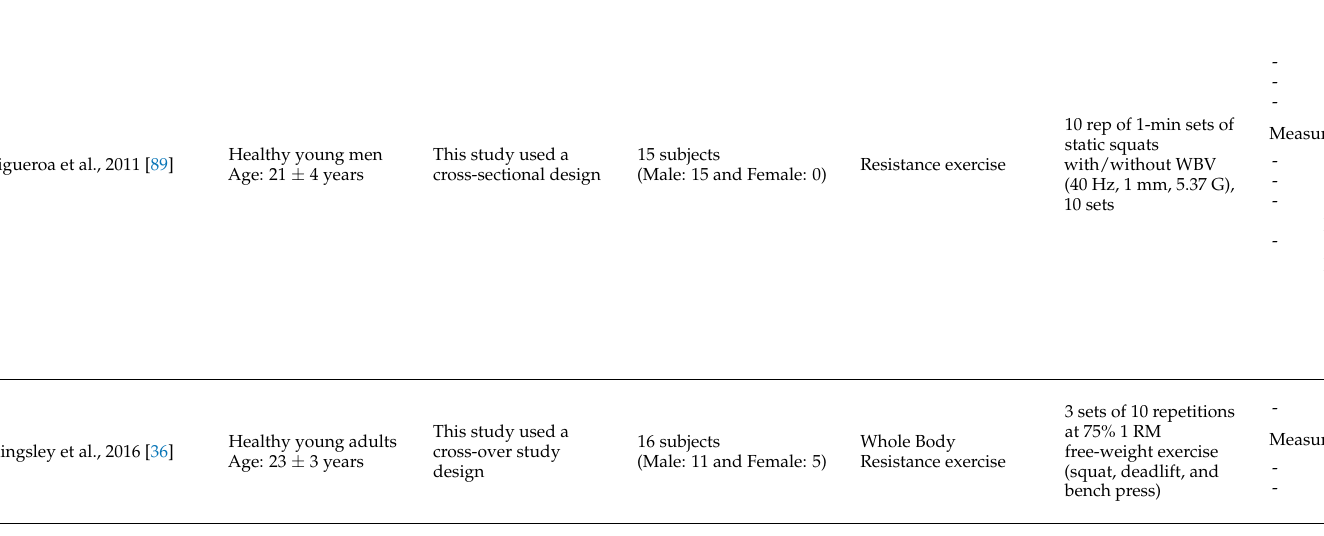
Table 2. Effect of aerobic exercise training on arterial stiffness.